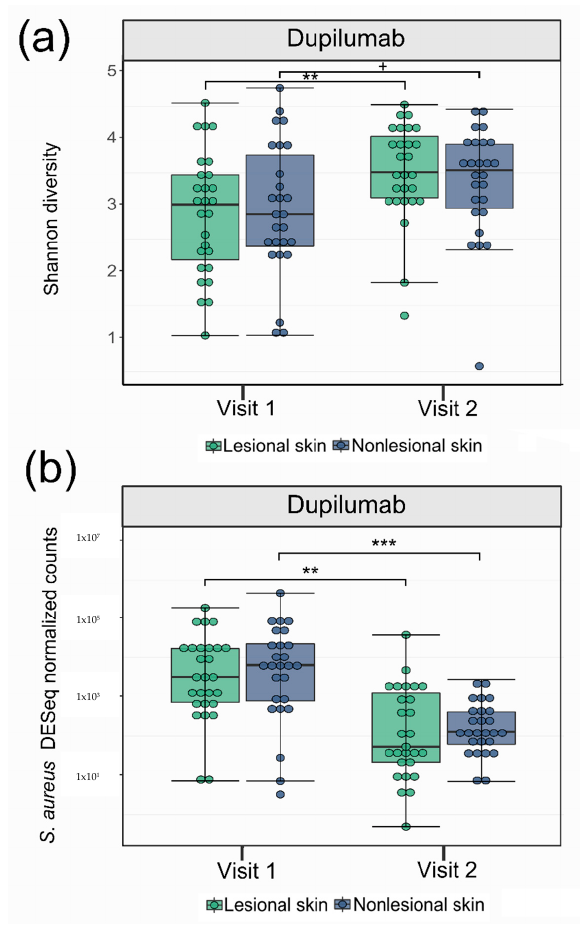
Figure 1. Shannon diversity and S. aureus relative abundance before and after treatment of atopic dermatitis patients with dupilumab. Boxplots showing ( a ) Shannon diversity and ( b ) Deseq2 normalized abundance of S. aureus in lesional and nonlesional skin at visit 1 and visit 2 for patients treated with dupilumab + = p < 0.1, ** = p < 0.01, *** = p < 0.001. Table 2. Treatment related changes in microbiome and staphylococcal species in the two treatment groups 1 .